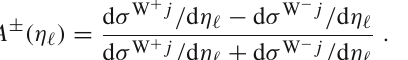
pidity A ± (η (cid:7) ) ,